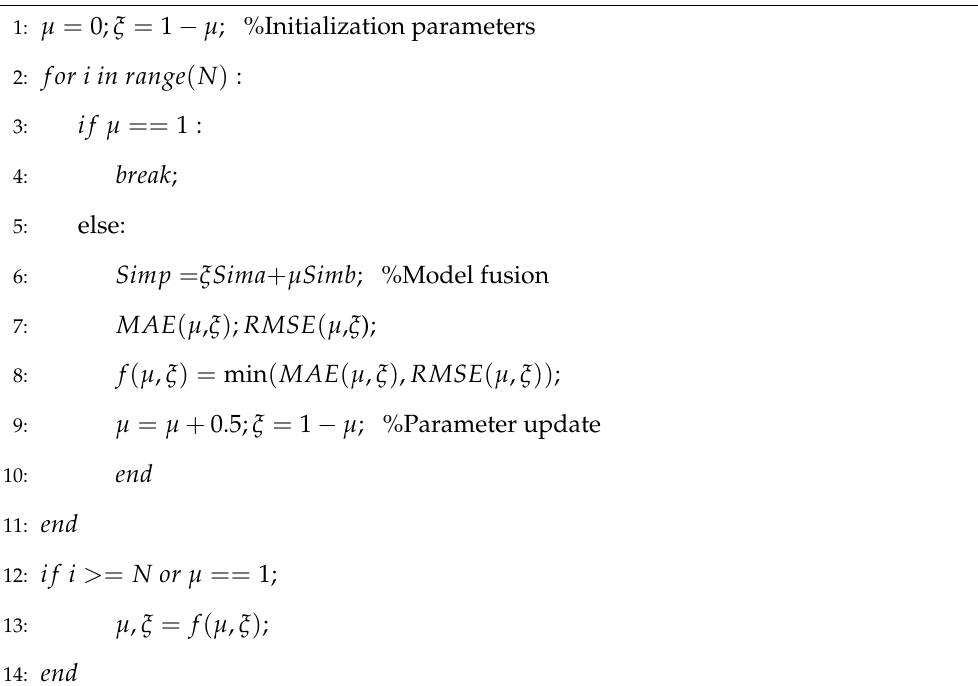
Algorithm 1 Optimal solution search